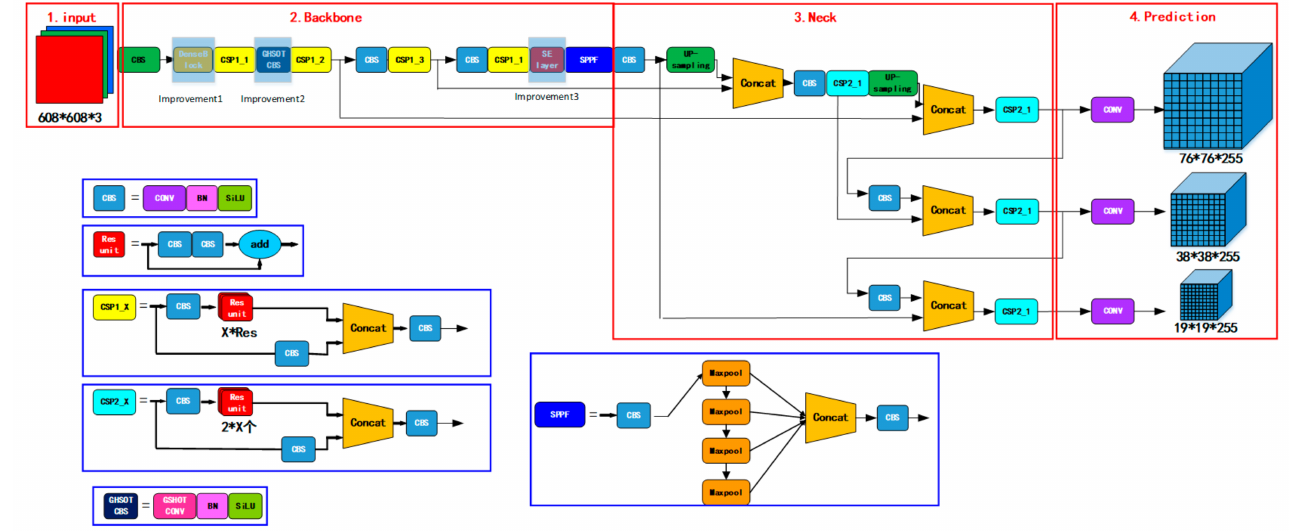
Figure 6. Improved YOLOv5 network.